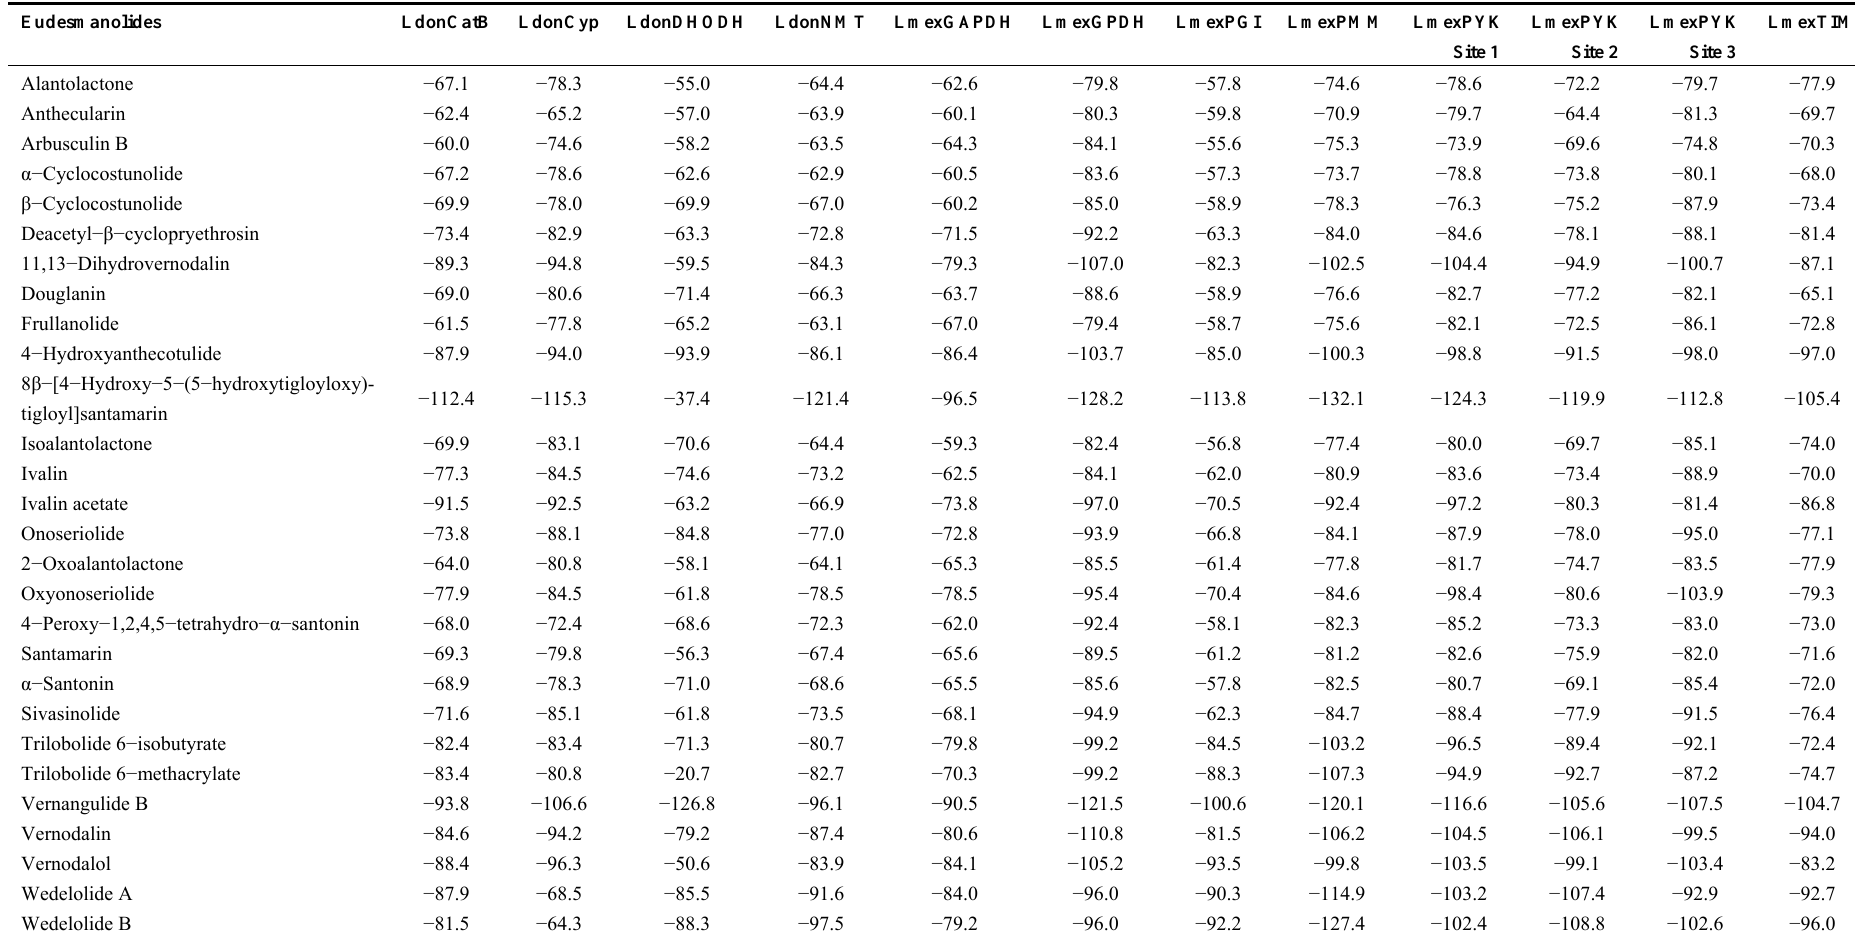
Table 11. MolDock docking energies (kJ/mol) of eudesmanolide sesquiterpenoids with Leishmania donovani and L. mexicana protein